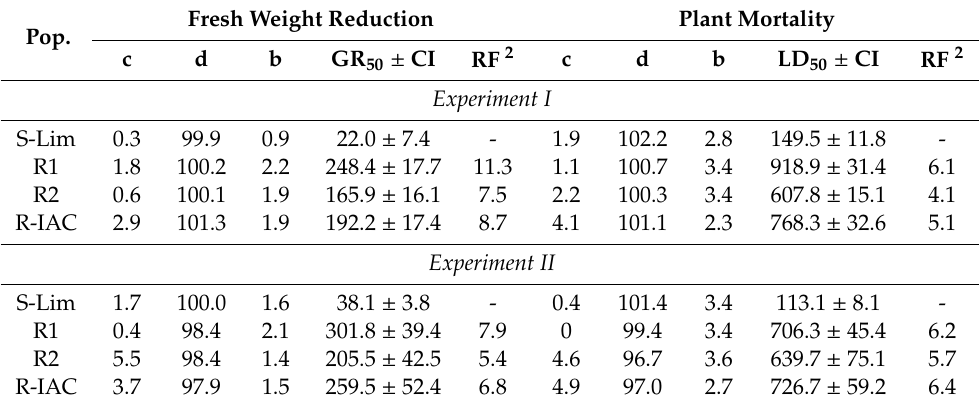
Table 1. Parameters of the sigmoidal equations 1 used to estimate the e ff ective mean dose (g ea ha − 1 ) of glyphosate required to reduce the fresh weight by 50% (GR 50 ) and to cause plant mortality (LD 50 ) by 50% in resistant (R1, R2 and R-IAC) and susceptible (S-Lim) slender amaranth ( Amaranthus viridis L.) populations (Pop.) collected in citrus orchards from S ã o Paulo State, Brazil.